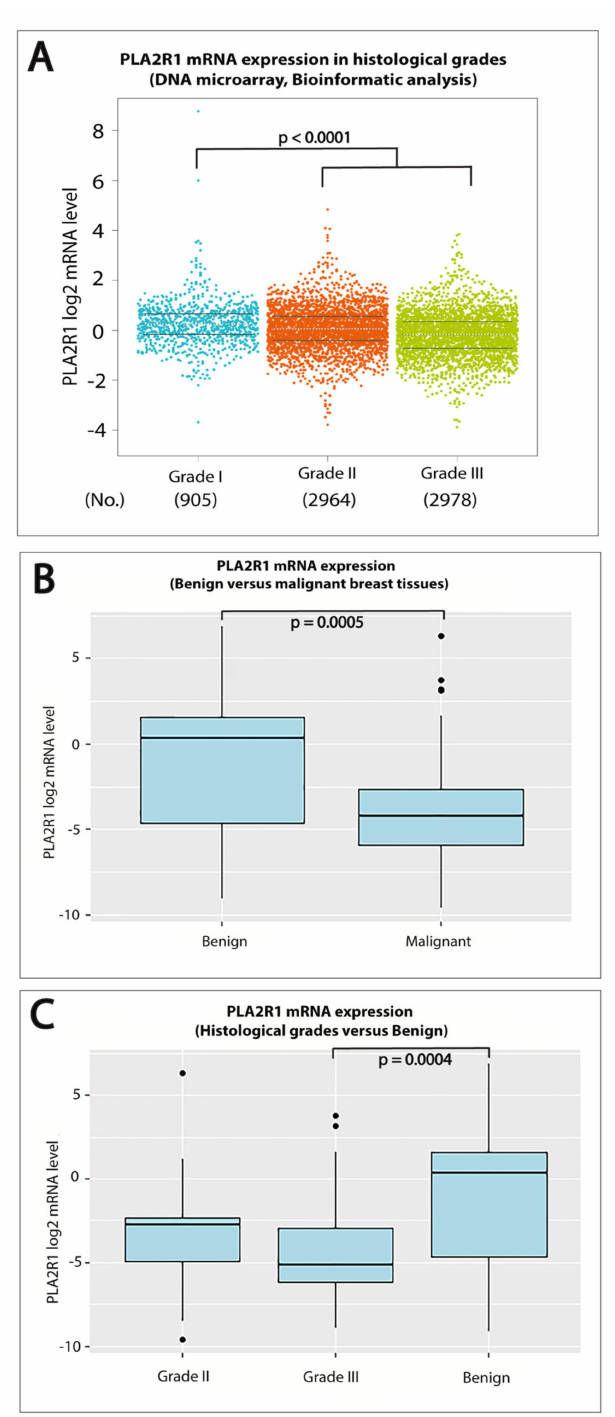
Figure 1. Differential expression of PLA2R1 among different histological grades of breast cancer compared to benign fibroadenomas. ( A ) Boxplots illustrating significantly lower expression levels of PLA2R1 mRNA in Grade II and III in comparison to Grade I breast cancer ( p < 0.0001) from the bc-GenExMiner DNA microarray database. ( B ) Levels of PLA2R1 mRNA were measured using RT-qPCR in benign and malignant breast tumors and normalized to GAPDH mRNA as reference gene. Boxplots showing the downregulation of PLA2R1 mRNA expression in malignant breast cancer tissues compared to benign controls ( p = 0.0005). ( C ) Boxplots depicting a significantly lower expression level of PLA2R1 mRNA in Grade III breast cancer compared to the benign controls ( p =